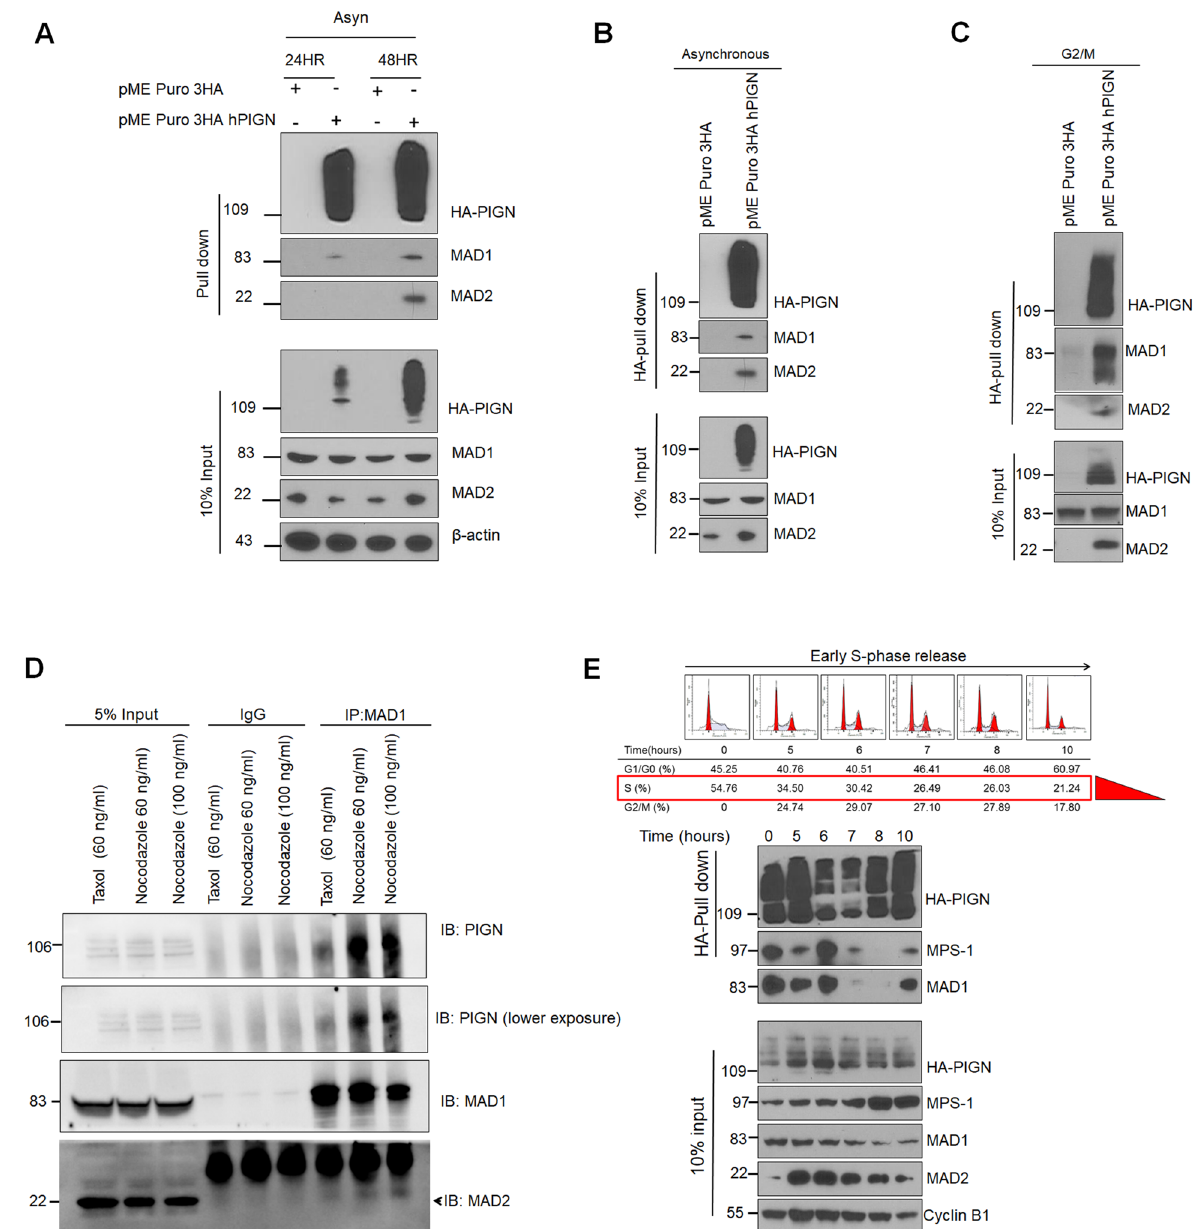
Figure 3. PIGN forms a complex with SAC components. MAD1 and MAD2 were co-purified with PIGN in an HA-tag pull-down assay in PIGN null HEK293 cells ectopically expressing 3HA-tagged PIGN. ( A,B ) HA-tag IP in asynchronous cells indicated optimal 3HA-tagged PIGN expression and co-purification with MAD1 and MAD2 at the 48-h time point. ( C ) MAD1 and MAD2 were co-purified with PIGN in G2/M synchronized cells. ( D ) Co-immunoprecipitation (Co-IP) experiment showed that PIGN endogenously interacted with MAD1 and MAD2 during SAC activation via Taxol (60 ng/µl) or nocodazole (60–100 ng/µl) treatment of K562 cells for 12 h. ( E ) HA-tag pull-down assay with cells released from early S-phase into mitosis indicated PIGN co-purification with MAD1 and MPS1. Inputs represent 5–10% of total protein lysate. All western blot images were cut within the molecular weight ranges of the protein targets prior to hybridization. Images generated from these cut blots by scanning the developed films. Images were cropped and labeled using Adobe Photoshop CC 2017 (version 18). Where applicable, representative full images of the blots are presented in Figure 3 of the supplementary immunoblotting